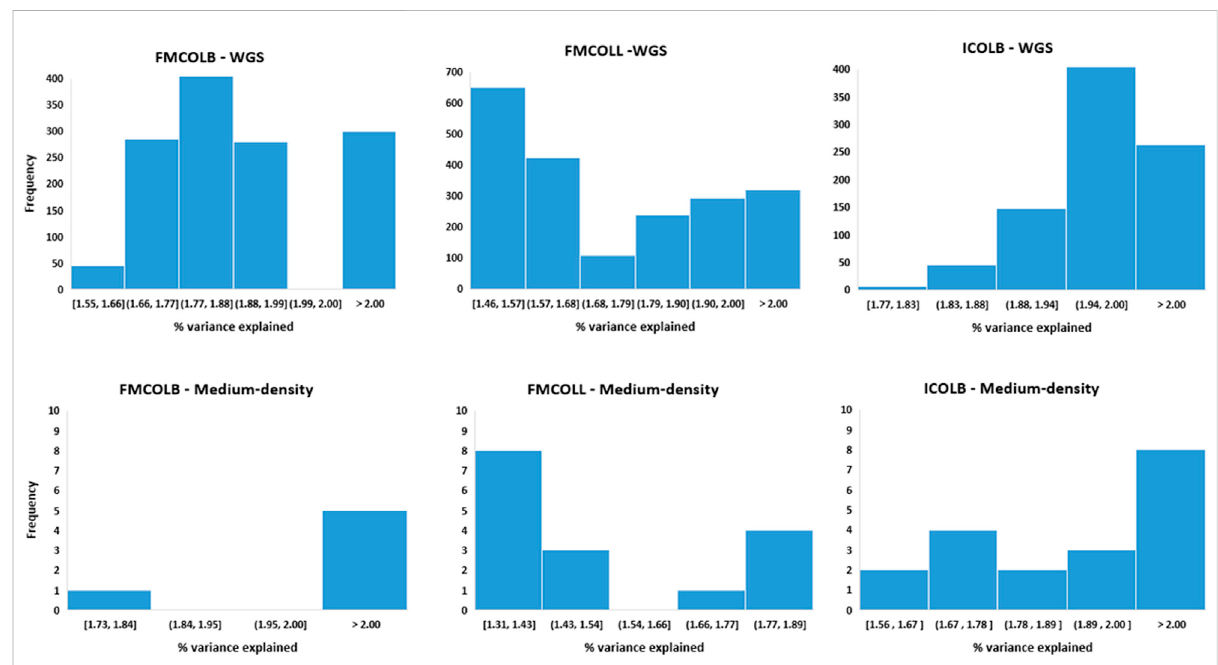
FIGURE 7 Distribution of the percentage of phenotypic variance explained by the most signi fi cant SNPs identi fi ed using different SNP densities (WGS (top row) and medium-density panels (bottom row)) for pork color traits (FMCOLB, FMCOLL, and ICOLB) in